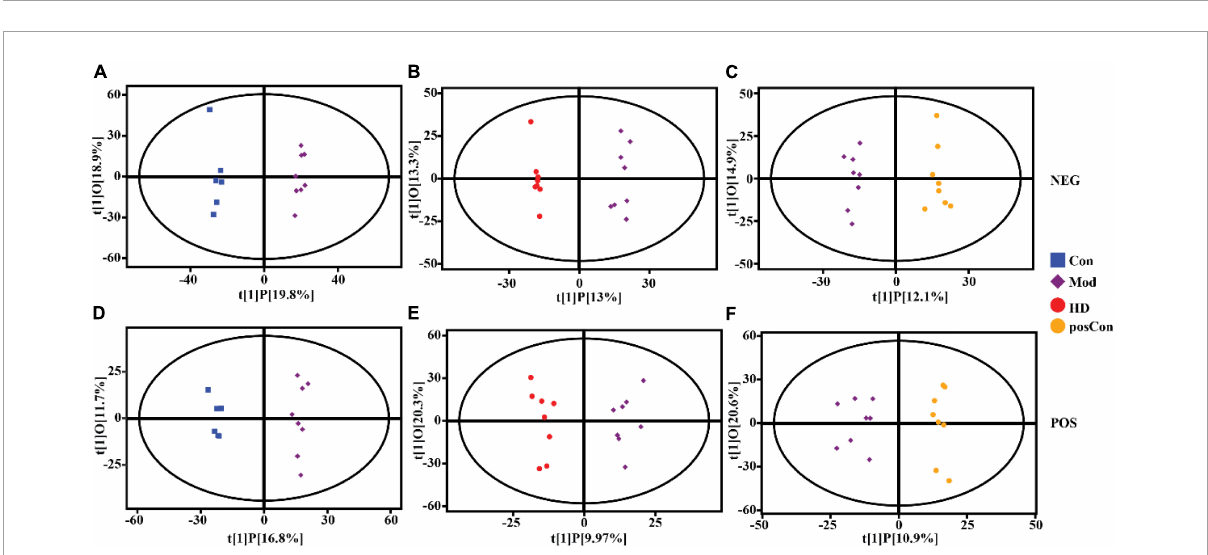
FIGURE3 OPLS-DA score scatter plots showing clustering of plasma metabolites detected in ESI- mode (NEG) and ESI + mode (POS). (A) Mod vs. Con (NEG, R 2 Y = 0.99, Q 2 = 0.87), (B) HD vs. Mod (NEG, R 2 Y = 0.99, Q 2 = 0.77), (C) posCon vs. Mod (NEG, R 2 Y = 0.98, Q 2 = 0.69), (D) Mod vs. Con (POS, R 2 Y = 0.99, Q 2 = 0.78), (E) HD vs. Mod (POS, R 2 Y = 0.96, Q 2 = 0.51), (F) posCon vs. Mod (POS, R 2 Y = 0.94, Q 2 =